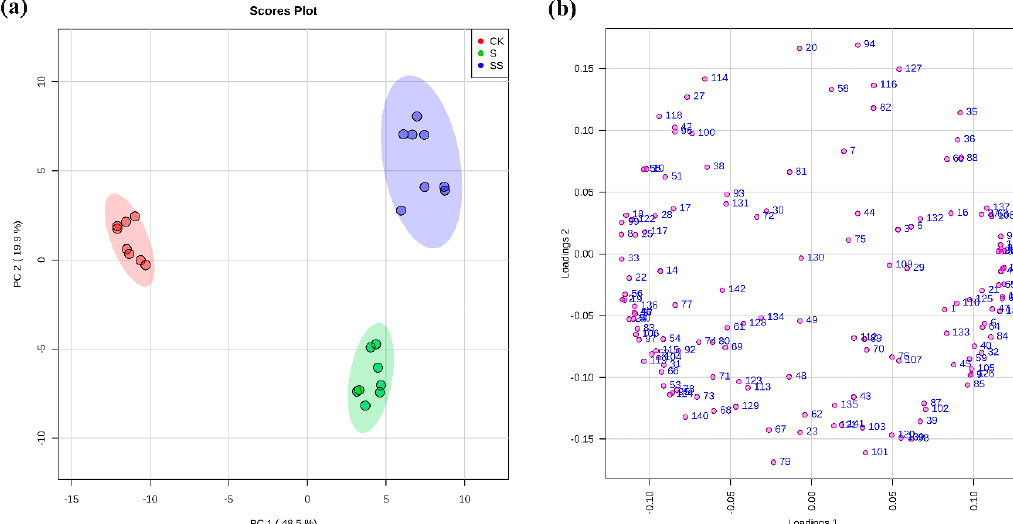
Figure 3. Principle components analysis (PCA) on metabolite profiles of the roots in cucumber seedlings under normal condition and salt stress with or without Spd. CK = control, S = 75 mM NaCl, SS = 75 mM NaCl + 0.1 mM Spd; ( a ) Scores plot; ( b ) Loading plot. Each number in loadings plot corresponds to a metabolite and its contribution to the principal components, as shown in Table S1.